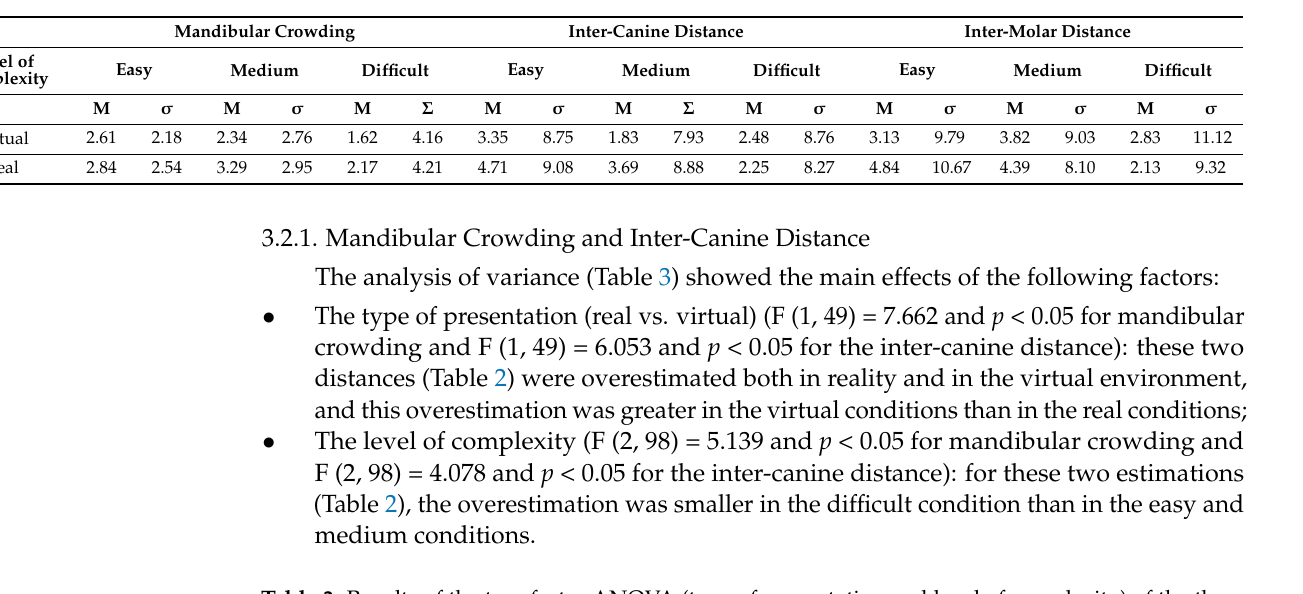
Table 3. Results of the two-factor ANOVA (type of presentation and level of complexity) of the three estimated distances (mandibular crowding, inter-canine distance, and inter-molar distance).